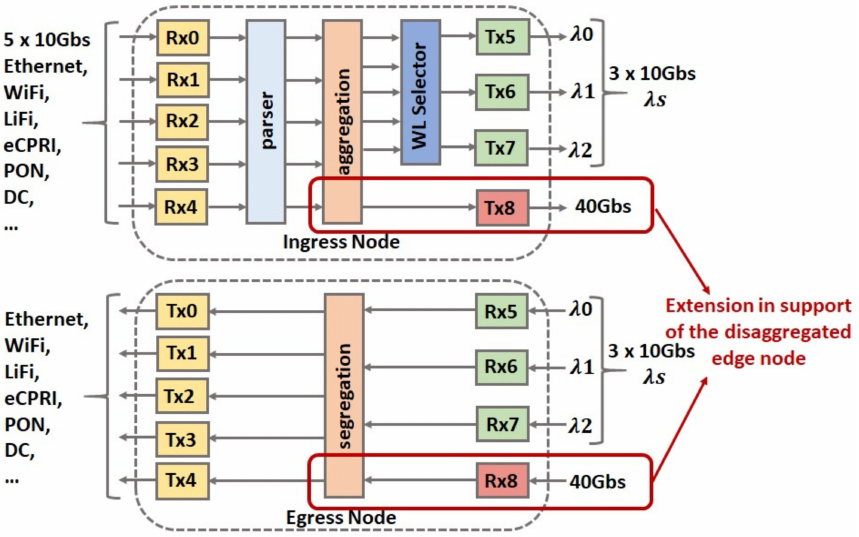
Figure 11. The TSON solution data plane architecture in support of the disaggregated edge